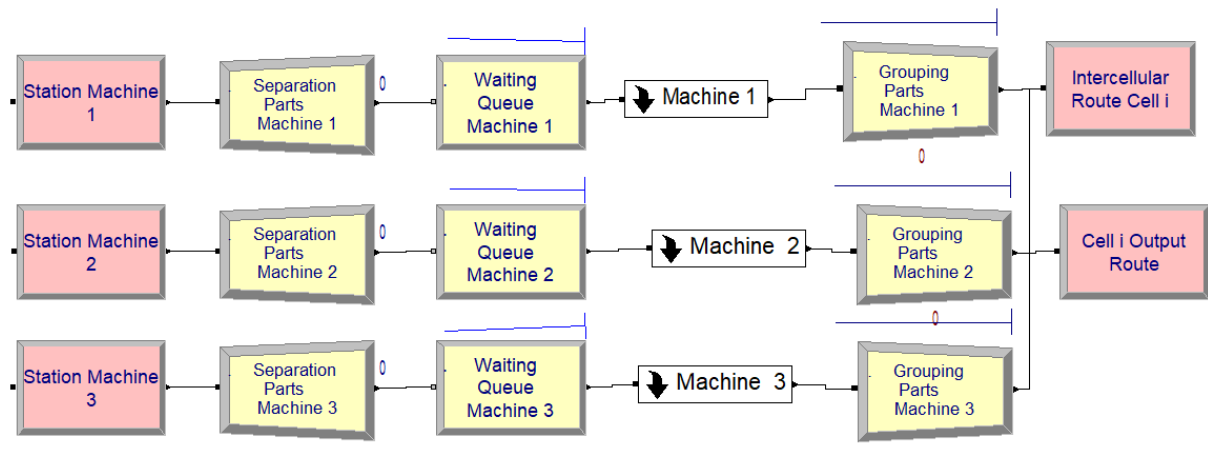
Figure 4. Simulation part model related to cell “i” .